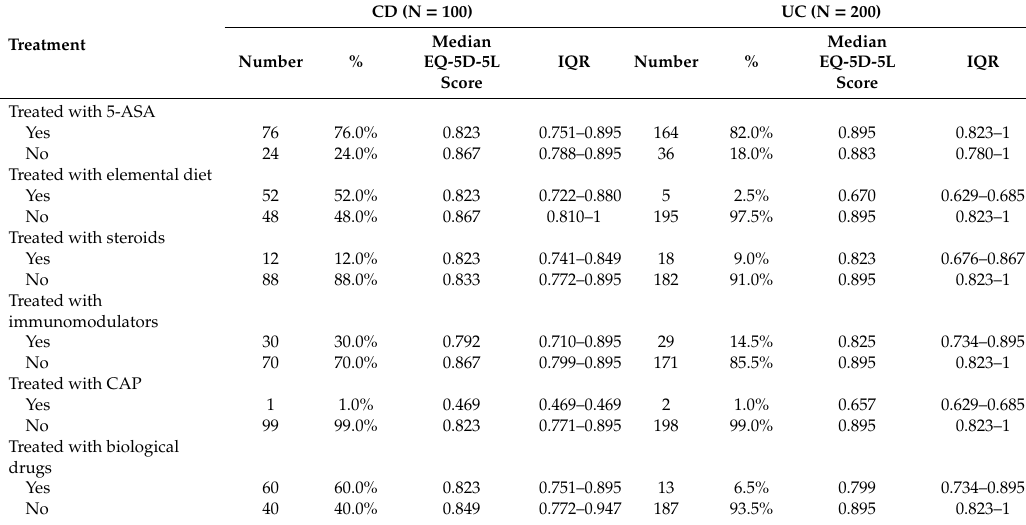
Table 2. Treatment status and utility